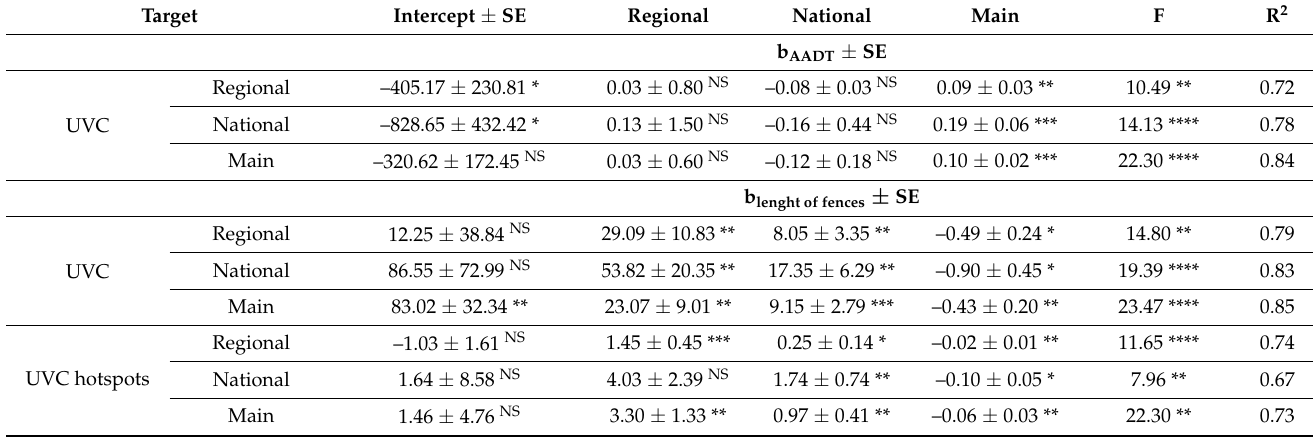
Table 2. Hypotheses that there are no relationship between UVC and UVC hotspots with AADT and fencing length patterns on different categories of roads declined with * p < 0.10, ** p < 0.05, *** p < 0.01, **** p < 0.001. NS: not significant. Response variables are UVCs and UVC hotspots on regional, national, and main roads; b AADT and b length of fences show the degree of change in the response variable for every 1-unit of change in the predictor